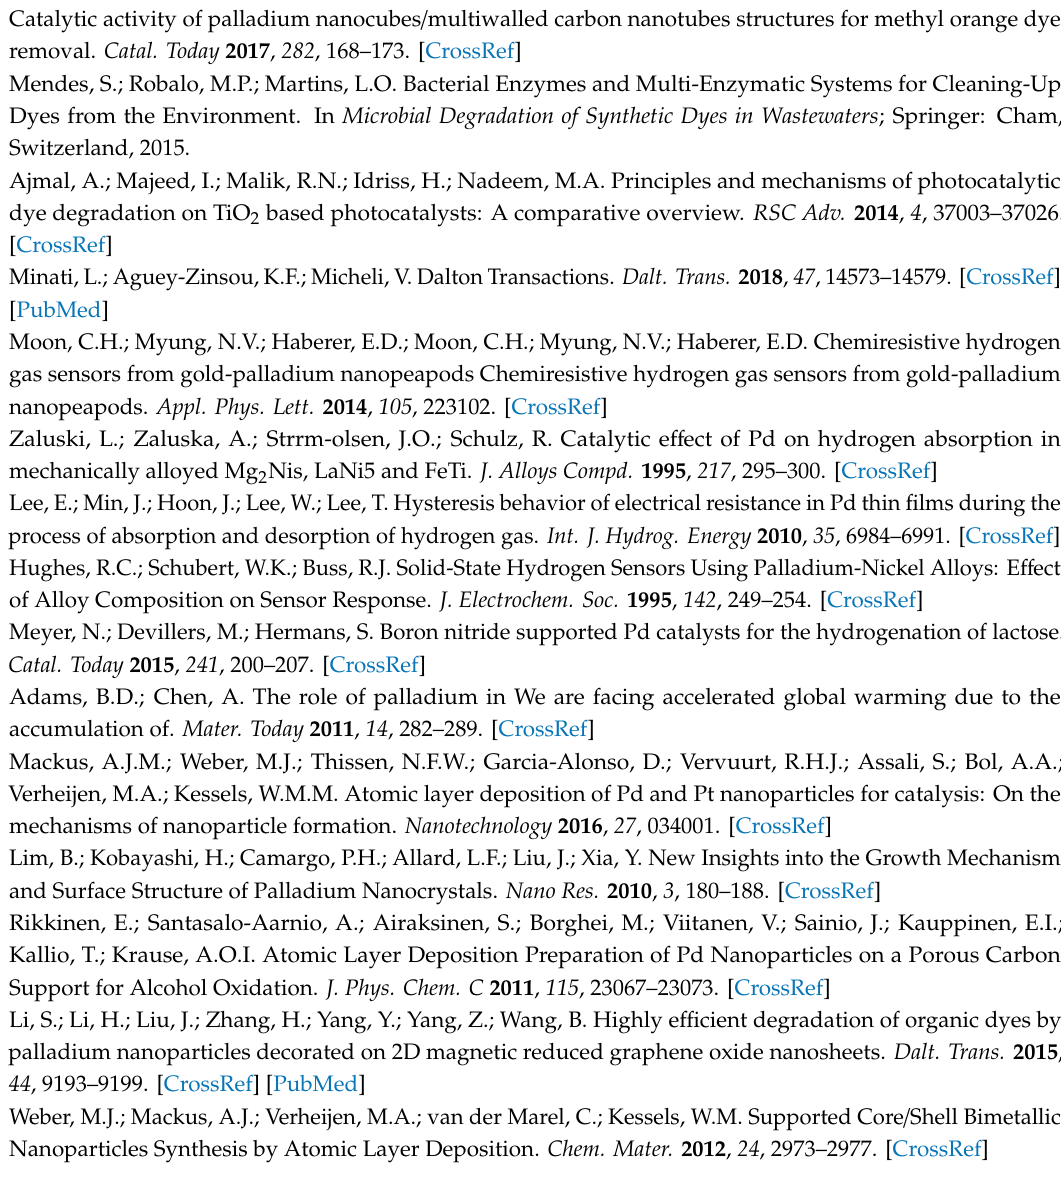
Figure S1: Summary of the whole original